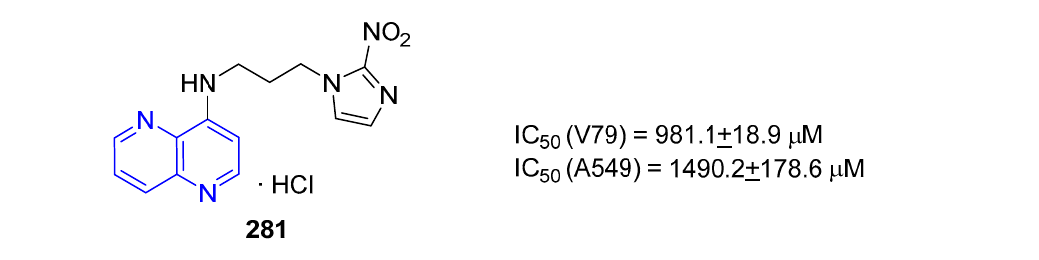
Figure 13. Cytotoxicity against cancer cells.